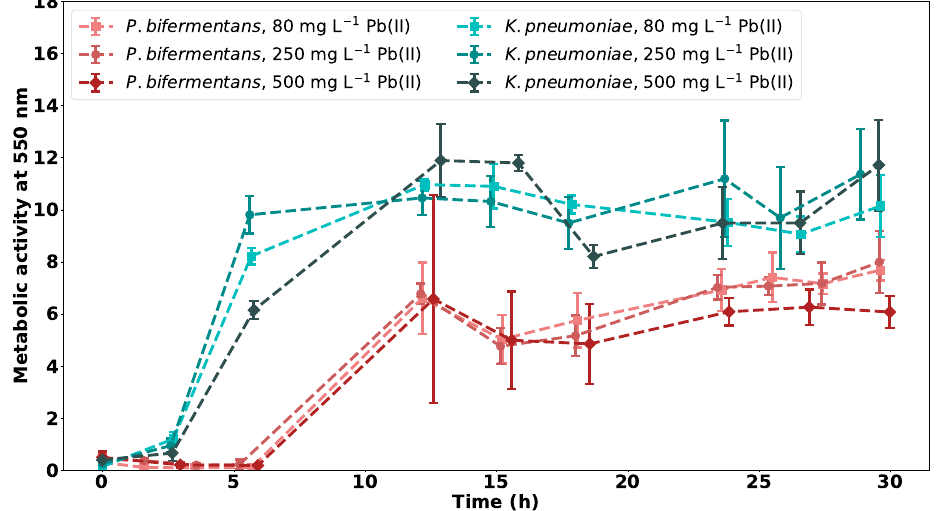
Figure 6. The metabolic activity at 550 nm for P. bifermentans and K. pneumoniae at varying initial Pb(II) concentrations, with n =